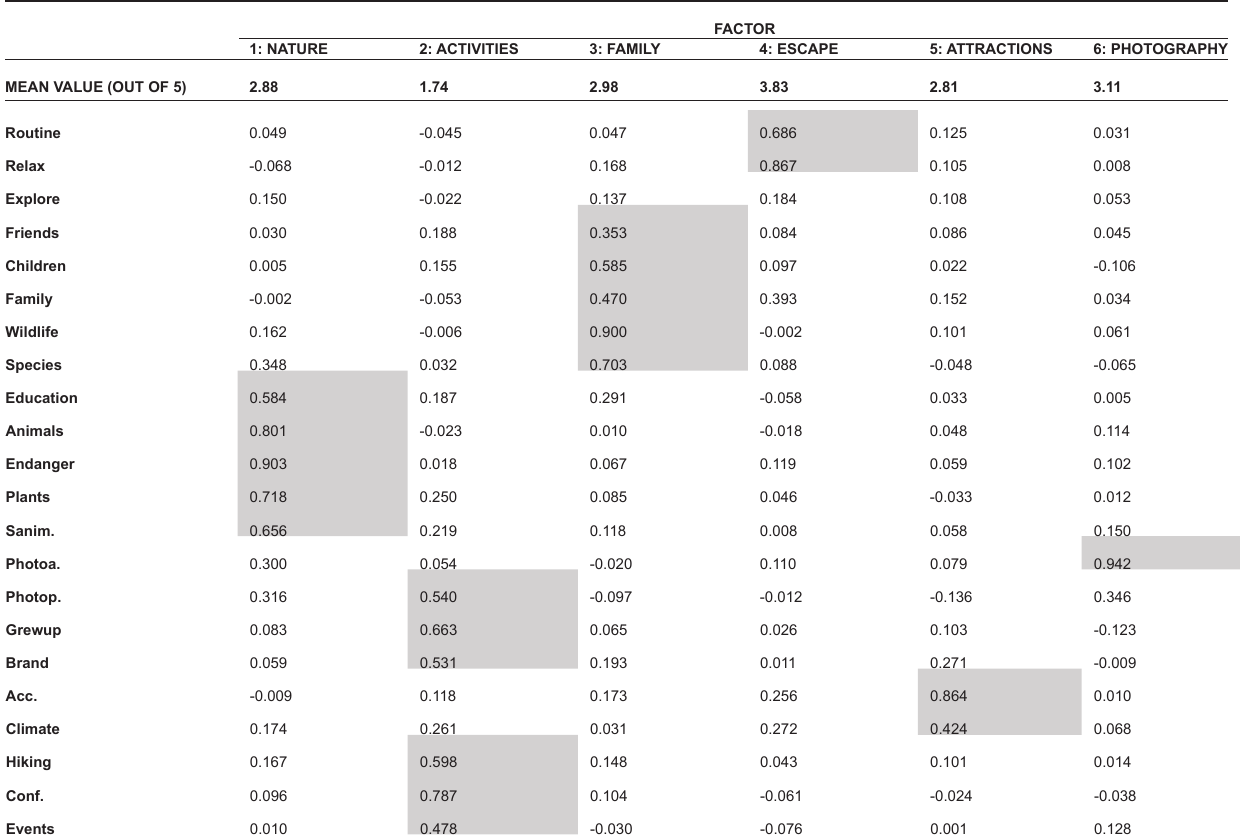
Table 3 Results of factor analysis conducted on motivational factors